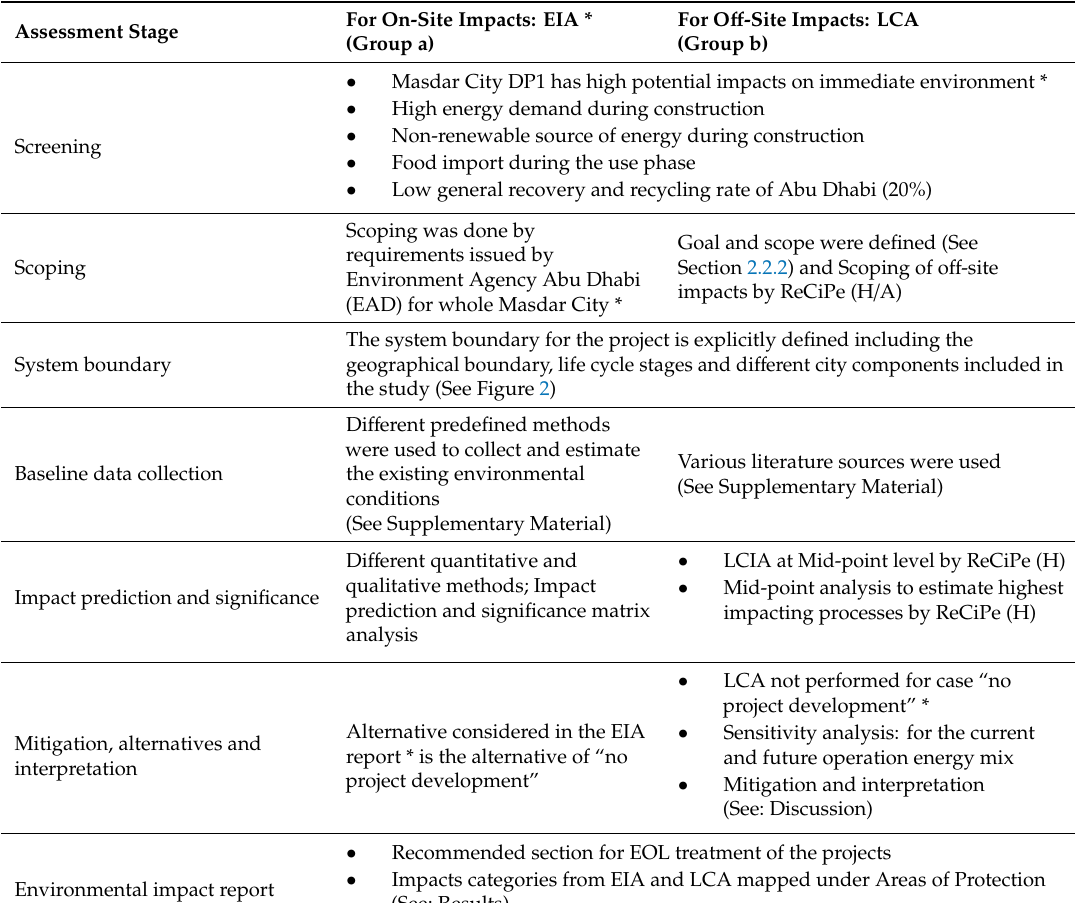
Table 2. Application of integration of EIA and LCA framework on Masdar City (DP1). * EIA report of Masdar City